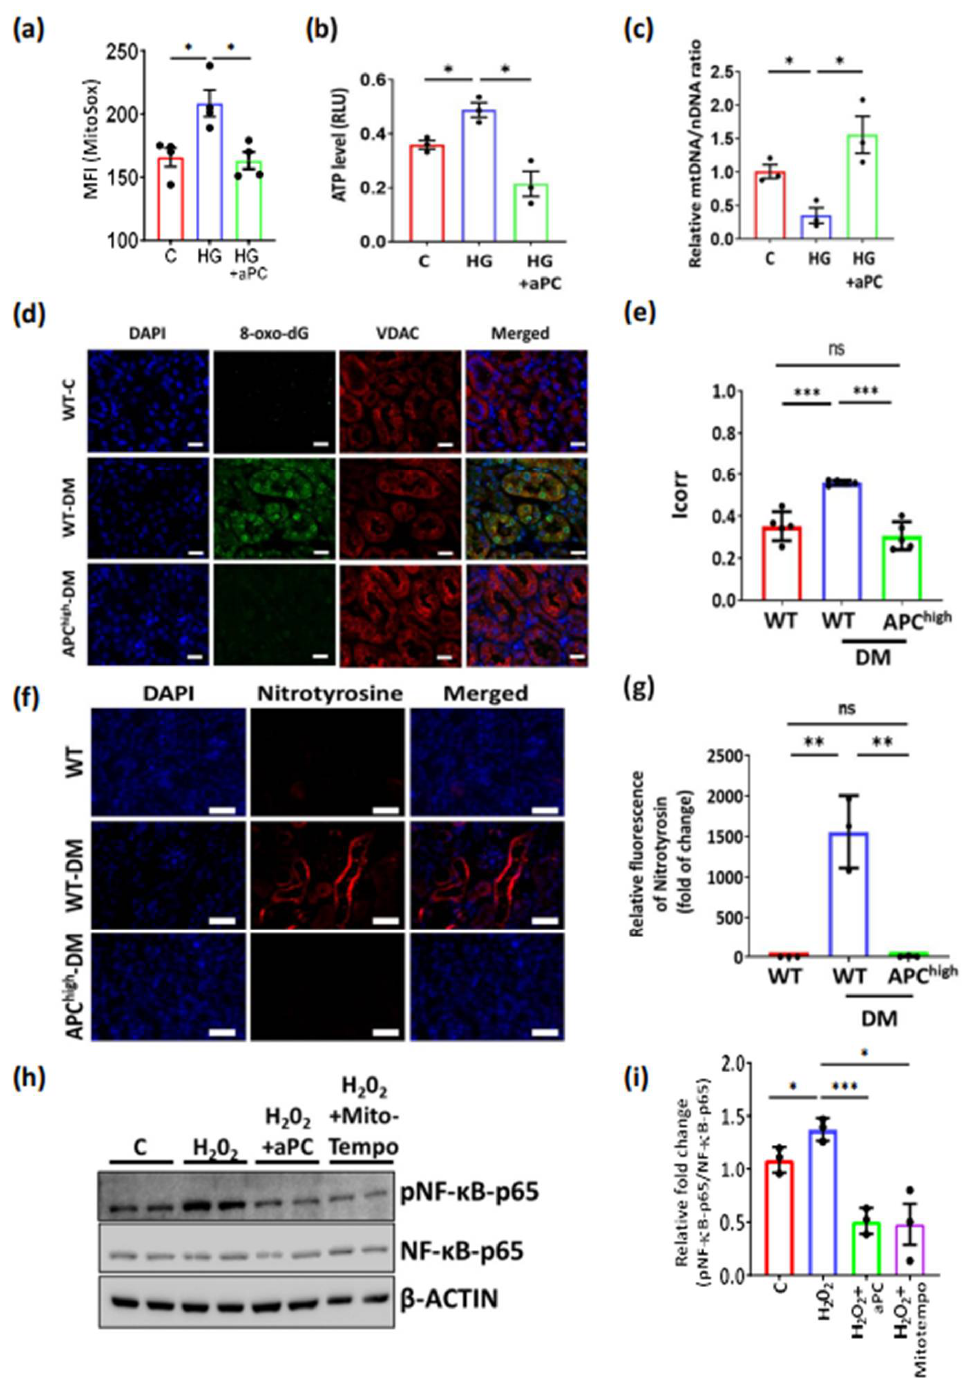
Figure 3. aPC reduces tubular ROS in diabetic nephropathy. ( a ) Bar graph with dot-plot summarizing staining intensity (mean fluorescent intensity, MFI) of the mitochondrial ROS marker MitroSox in tubular cells without (C) or with (HG) exposure to high glucose (25 mM, 24 h). A subgroup of cells was pretreated with aPC (20 nM, 1 h: HG + aPC). ( b ) ATP levels were measured using a lucif- erin-luciferase assay in control (normal glucose, 5 mM) and high glucose (25 mM)-treated BUMPT cells without (HG) or with aPC pretreatment (20 nM, 1 h, HG + aPC); RLU (relative light unit) after normalization for cell number of each sample. ( c ) Relative quantification was performed using qRT- PCR by amplification of ND2 and normalized against the hexokinase gene (HK). ( d , e ) Representa- tive images of immunohistochemical staining of 8-oxo-dG and VDAC and dot plots showing Icorr scores for 8-oxo-dG and VDAC colocalization in mouse kidneys obtained from nondiabetic wild- type (WT-C), diabetic wild-type (WT-DM), or diabetic APC high mice (APC high -DM); scale bar: 20 µm. ( f , g ) Representative images of the immunohistochemical staining of nitrotyrosine (red; DAPI nu- clear counterstain, blue) in the tubular compartment of mouse kidney; groups as in c and ( g ) bar graphs with dot summarizing results. ( h , i ) Representative immunoblots and ( i ) bar graphs with dot plots summarizing the data of phospho-p65-NF-ĸB in BUMPT cells stimulated by H 2 O 2 (H 2 O 2 , 100 µM/24 h) or with pretreatment with aPC (20 nM, 1 h) or Mito-Tempo (10 µM, 1 h); nonphosphory- lated p65 NF-ĸB as a control, β-actin: loading control. * p < 0.05; ** p < 0.01; *** p < 0.001 ( a – c , e , g , i ). Statistical analyses were performed using one-way ANOVA with Sidak’s multiple comparison test.